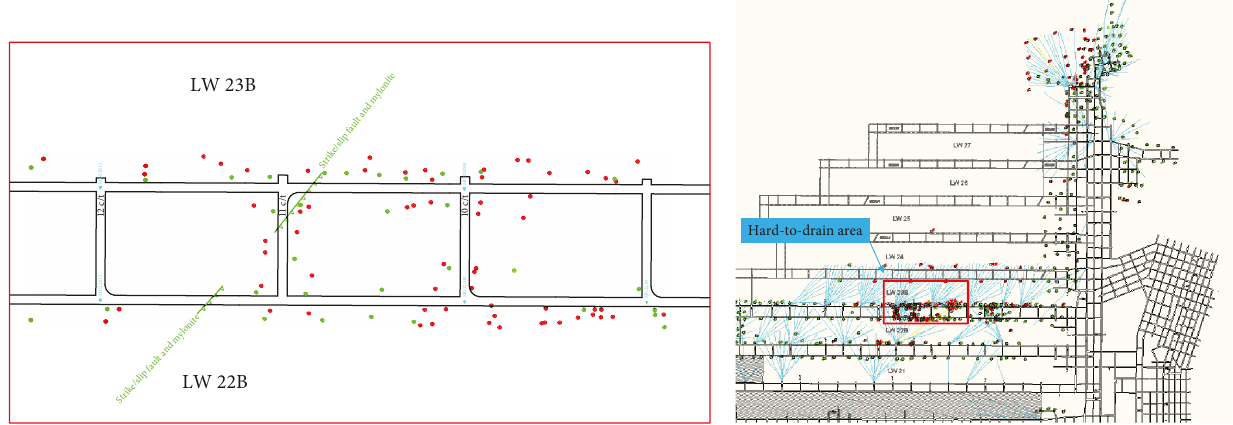
Figure 2: Metropolitan mine plan showing the “ hard-to-drain ” area 3. An evaluation of gas drainability from the coal Table 1: Coal proximate analysis.